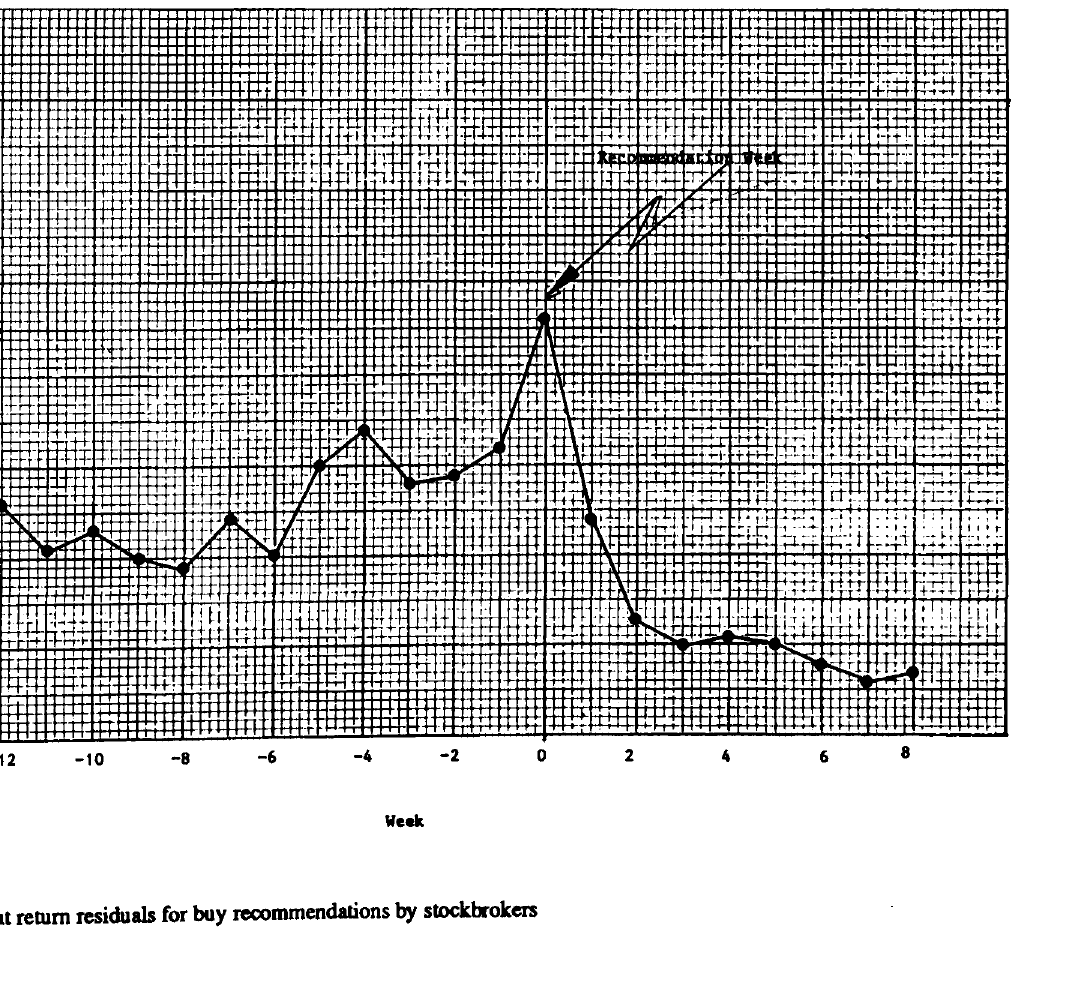
Flgure I Weekly investment return residuals for buy recommendations by